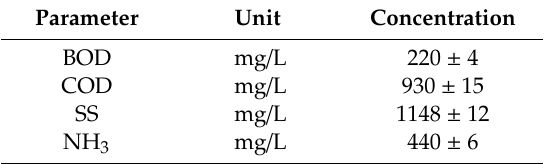
Table 2. The initial BOD, COD, SS, and NH 3 concentrations were determined in untreated SRPE.